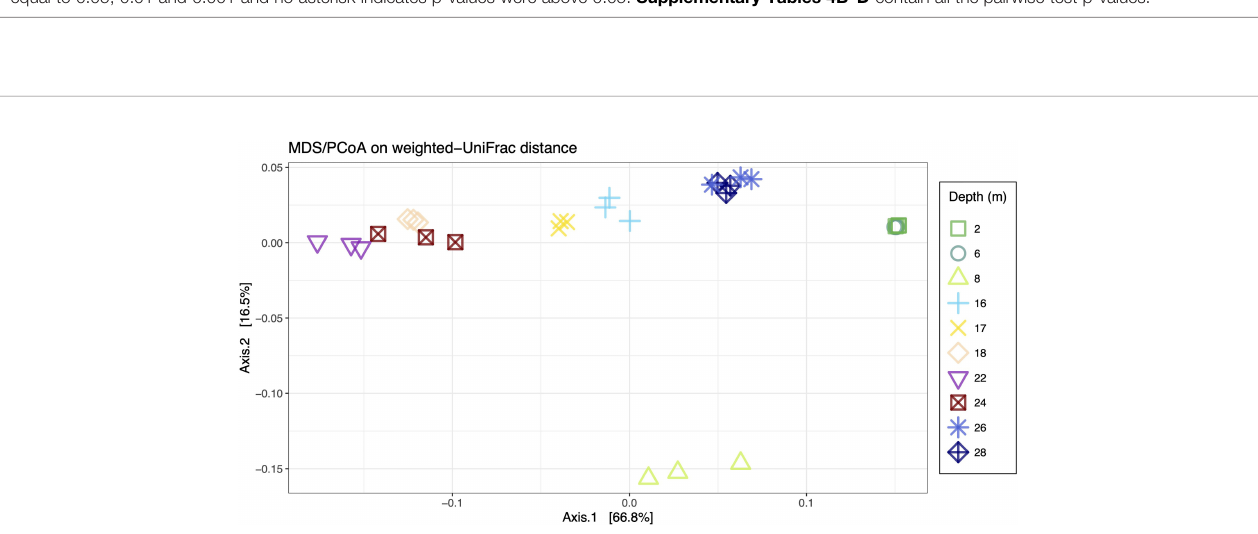
FIGURE 4 | Two dimensional plot of PCoA analysis showing the fi rst two axes which captured approximately 80% of the total variance. Inter-sample distances were calculated on weighted-Unifrac